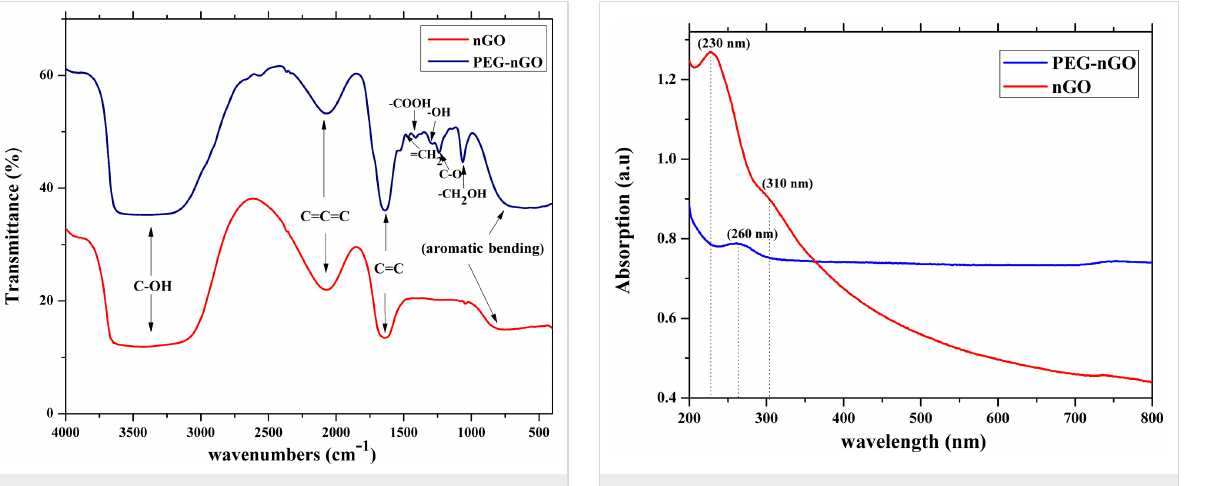
In the case of nGO, a broad absorption band in the range of 3700–3000 cm − 1 indicates the presence of free and intermolecu- lar bonded hydroxy groups. The allene symmetry of nGO is recognized by an absorption band at 2000 cm − 1 . Another absorption band at 1650 cm − 1 appears due to stretching of the cyclic alkene (C=C). The absorption band at 800 cm − 1 appears